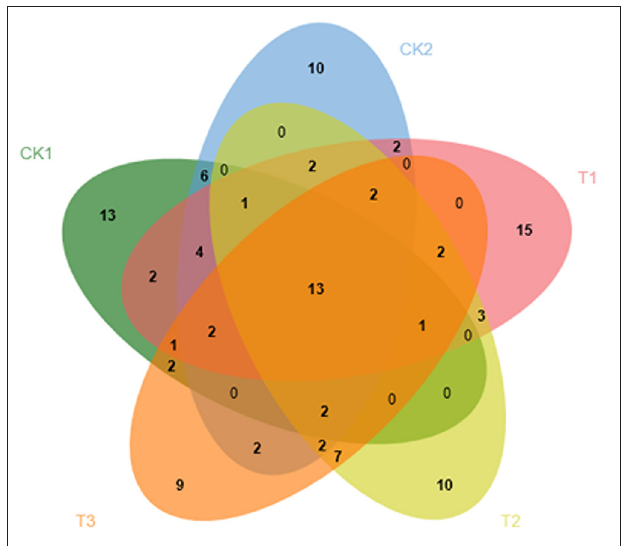
FIGURE 5 | Effects of different ground mulching patterns on common and specific volatile compounds in loose-curd cauliflower heads.